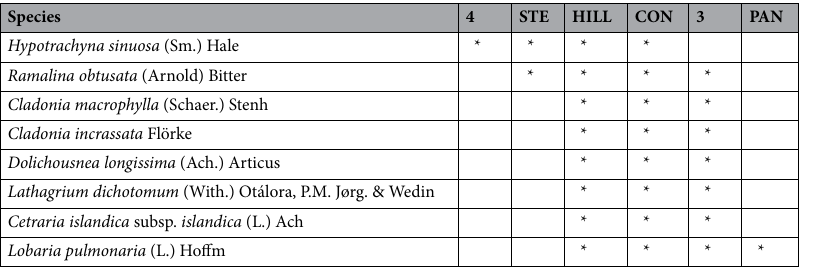
Table 3. The ordering of RLL species in the geomorphological units and biogeographical regions over time within the PAs (according to the seriation analysis performed with the PAST software, based on unconstrained algorithm). 3–1951–2000; 4–2001–2020; asterisks indicate the occurrence of RLL species in the geomorphological units and biogeographical regions over time; empty cells indicate no available